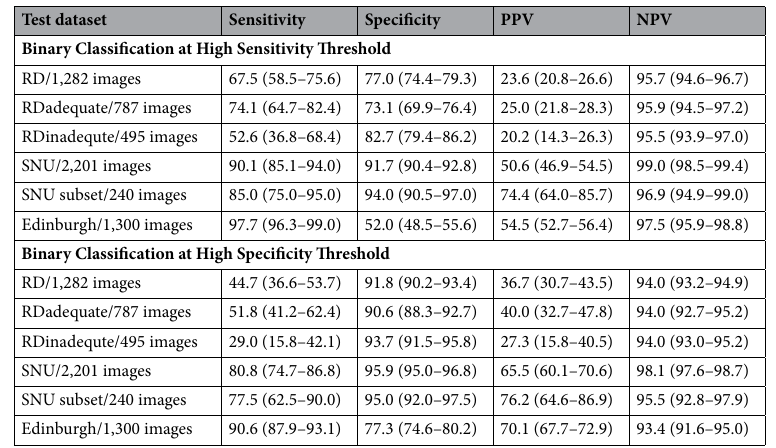
Table 2. Sensitivity, specificity, positive predictive value, and negative predictive value in the binary-class classification. PPV positive predictive value, NPV negative predictive